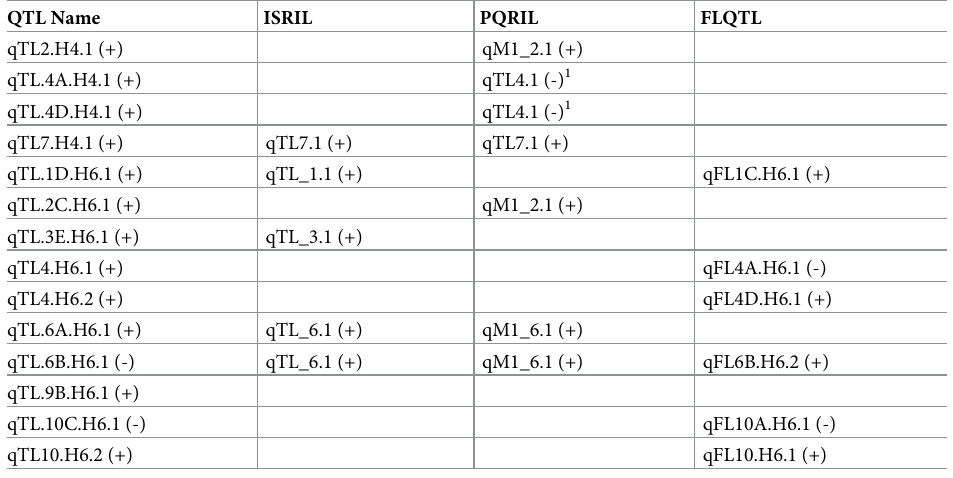
Table 3. Comparisons of TL and FL QTL in the SBSH-BC 1 F 2 , IS-RIL and PQ-RIL